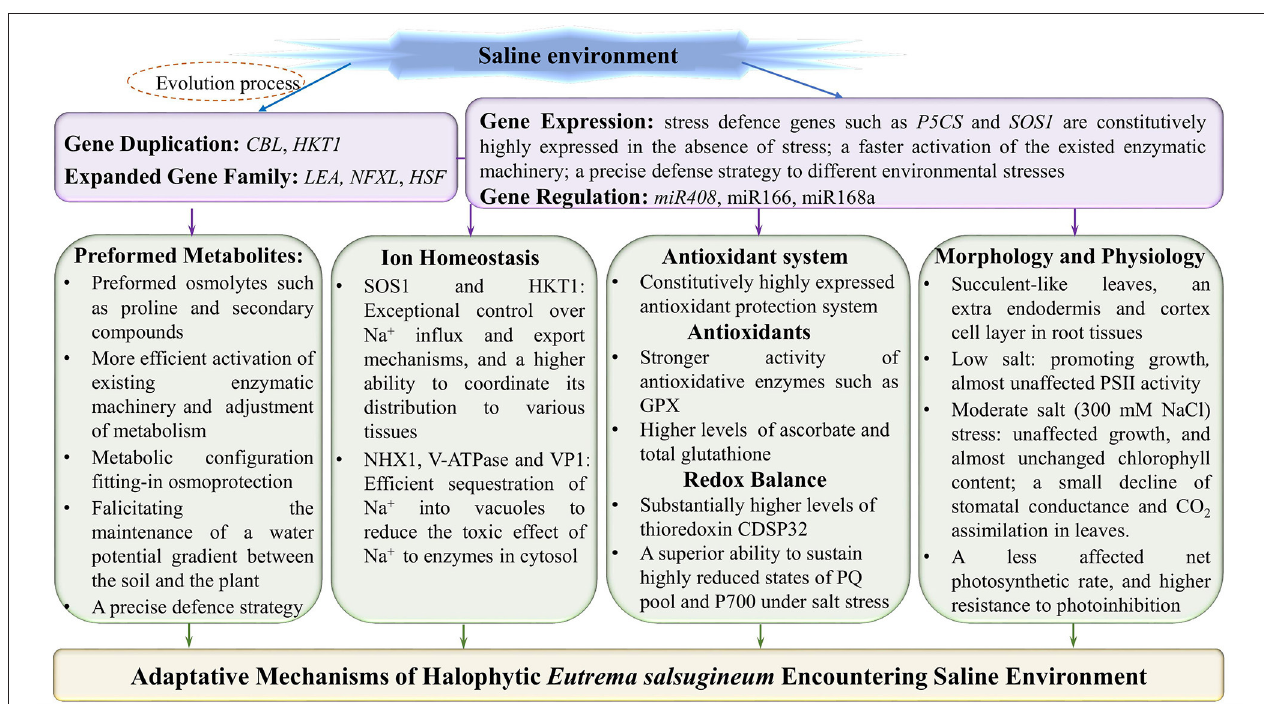
FIGURE 2 | Adaptative mechanisms of halophytic Eutrema salsugineum encountering saline environment. The adaptative mechanisms of Eutrema plants to saline stress are mainly including: (1) The adaptive evolution endowing E . salsugineum plants with the expanded defense related genes and/or gene family members to facilitate plants more flexibility in response to salinity stress; (2) The constitutive higher expression of stress defense genes such as P5CS and SOS1 in the absence of salt stress; (3) Anticipatory prepared osmolytes such as proline and secondary compounds, and a higher efficience to activate the existed enzymatic machinery as well as the adjustment of metabolism; (4) The halophytic E . salsugineum possessing exceptional control over Na + influx and export mechanisms, the superior ability to coordinate its distribution to various tissues, and the efficient sequestration of Na + into vacuoles; (5) A constitutively upregulated antioxidative protection system, and the effective regulation of redox status in halophytic Eutrema ; (6) The succulent-like leaves, an extra endodermis and cortex cell layer in root tissues, and higher density of stomata exhibitting a more tightly closing when responding to salt stress, as well as an almost unaffected net photosynthetic rate, in the lower or even moderate concentration of salinity. SOS1, salt overly sensitive 1 (plasma membrane Na + /H + antiporter); NHX, vacuolar Na + /H + antiporter; V-ATPase, vacuolar H + -ATPase; VP1 (V-Ppase), vacuolar H + -translocating inorganic pyrophosphatase (vacuolar H + -pyrophosphatase); HKT1, group 1 high-affinity K + transporter; GPX, glutathione peroxidases; PSII, photosystem II; PQ,